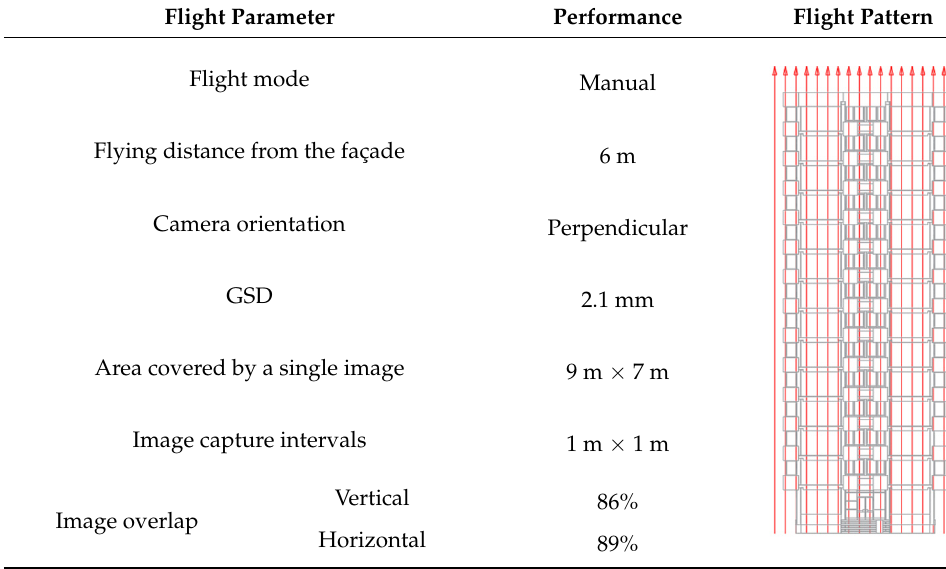
Table 2. Details of the flight plan.